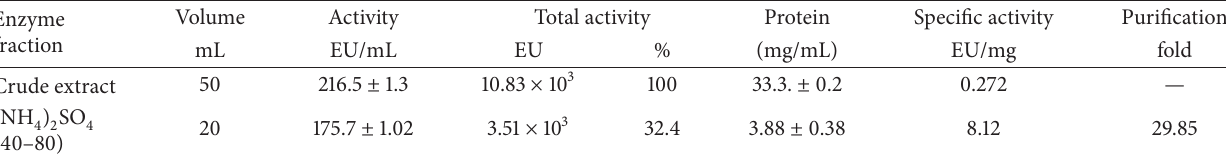
Table 1: The purification process of purified peroxidase enzyme from Euphorbia ( Euphorbia amygdaloides ).